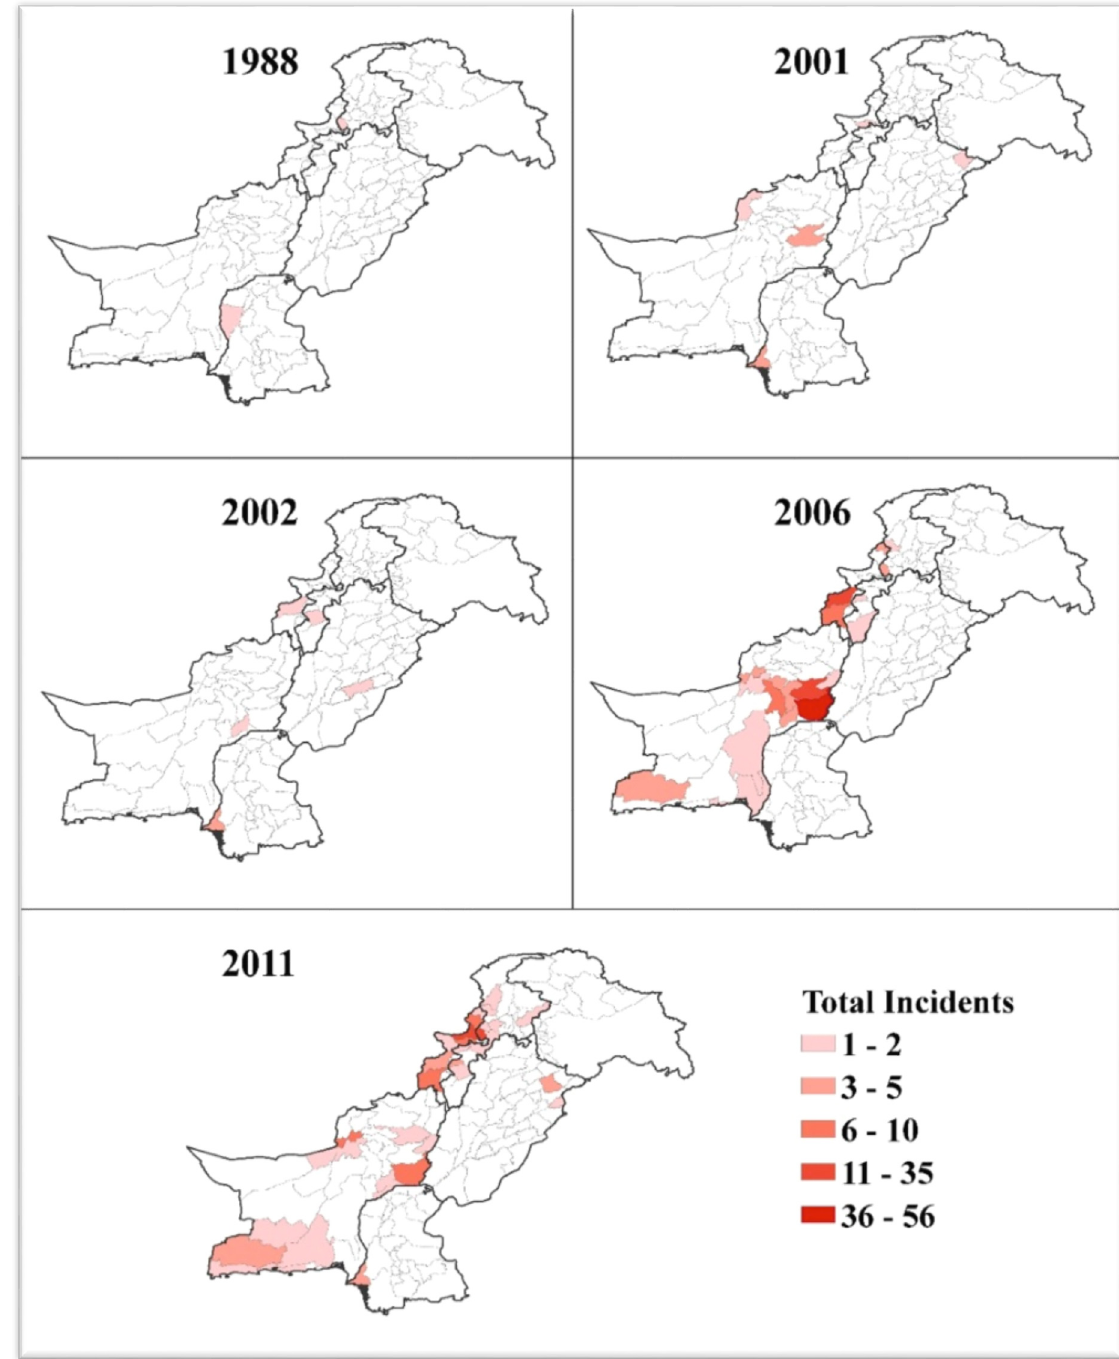
Figure 5. Militant/Guerilla Violence in Pakistan-Selected Years. Source: In-house manipulations of BFRS dataset [29,61] by Jesse